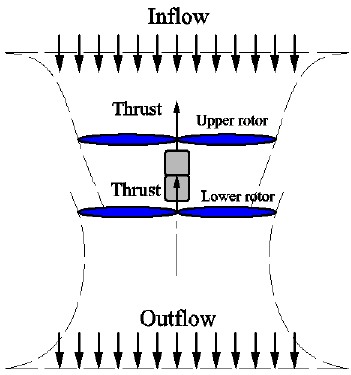
Figure 2. Direction of airflow a coaxial rotor pair without wind disturbance.